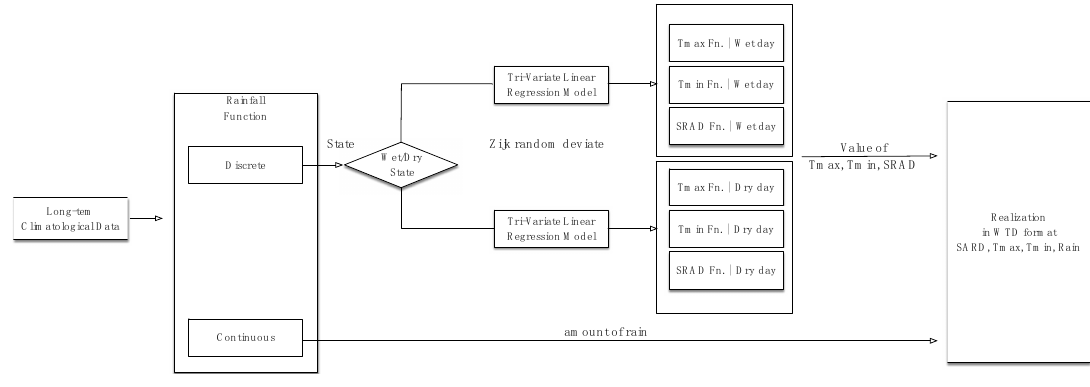
Figure 2. Overview functions of DisAg weather generator.